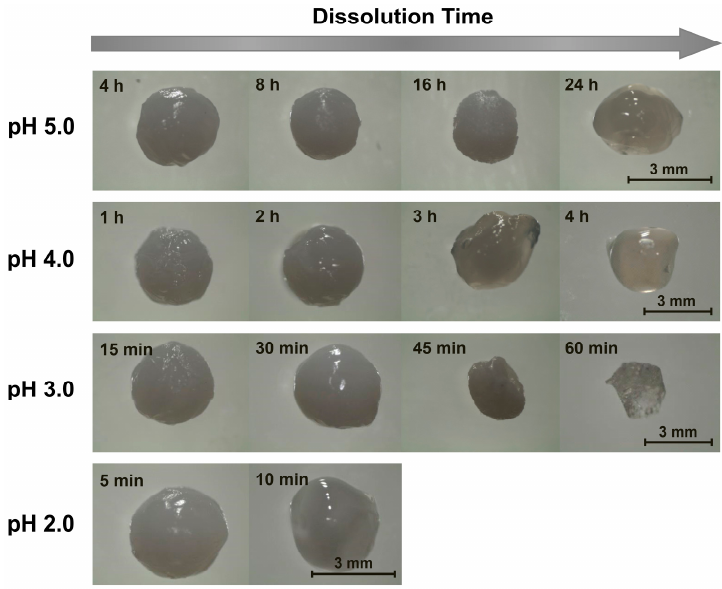
Figure 1. Representative images of alkaline solution-derived chitosan beads dissolving in pH 1.2–5.0 aqueous solutions ([NaCl] = 10 mM).